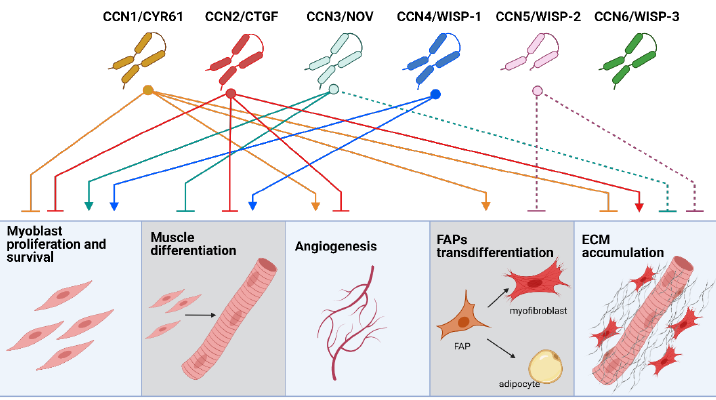
Figure 2. Schematic representation of the described roles for CCNs in skeletal muscle function. Each CCN connects with an arrow when it facilitates a specific process and connects with a blunt line when it inhibits a process. Dotted lines correspond to extrapolated data from cardiac muscle, which has not yet been confirmed in skeletal muscle. Figure created with BioRender.com (accessed on 14 May